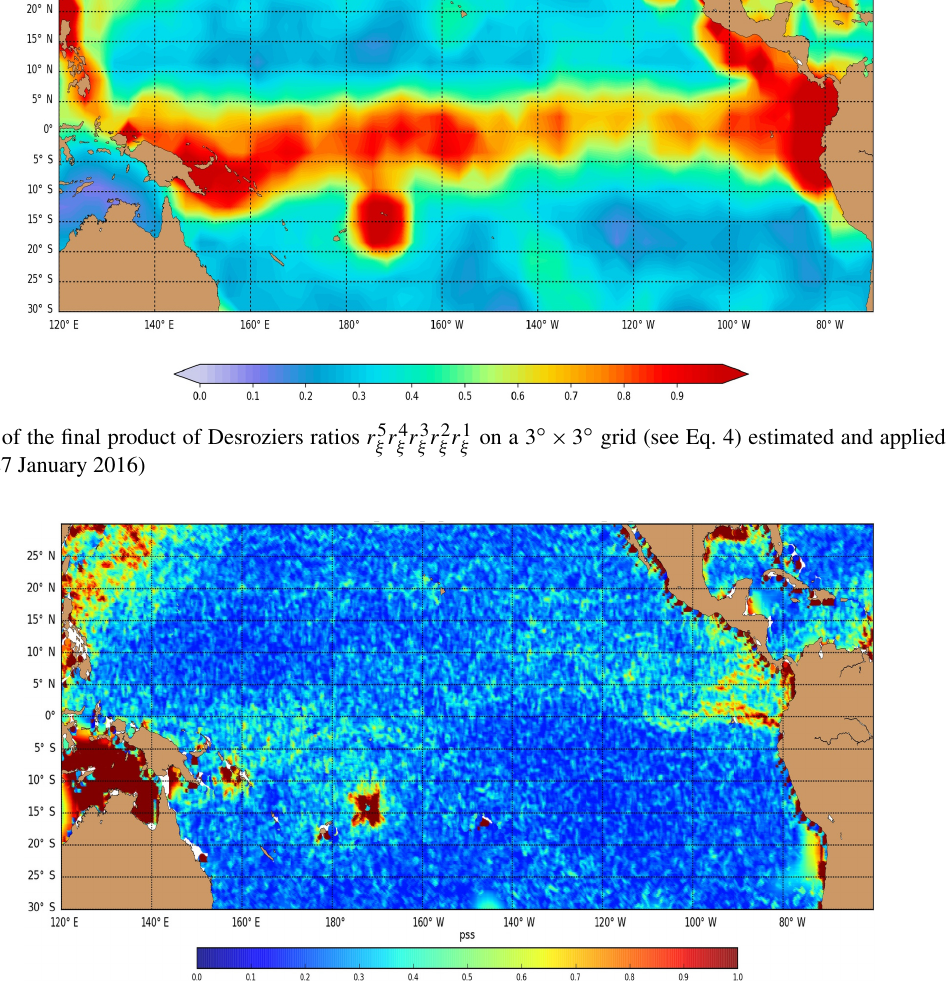
Figure 5. Example of SSS error (Eq. 6) of SMOS over the tropical Pacific used in the data assimilation system for the week of 20–27 Jan- uary